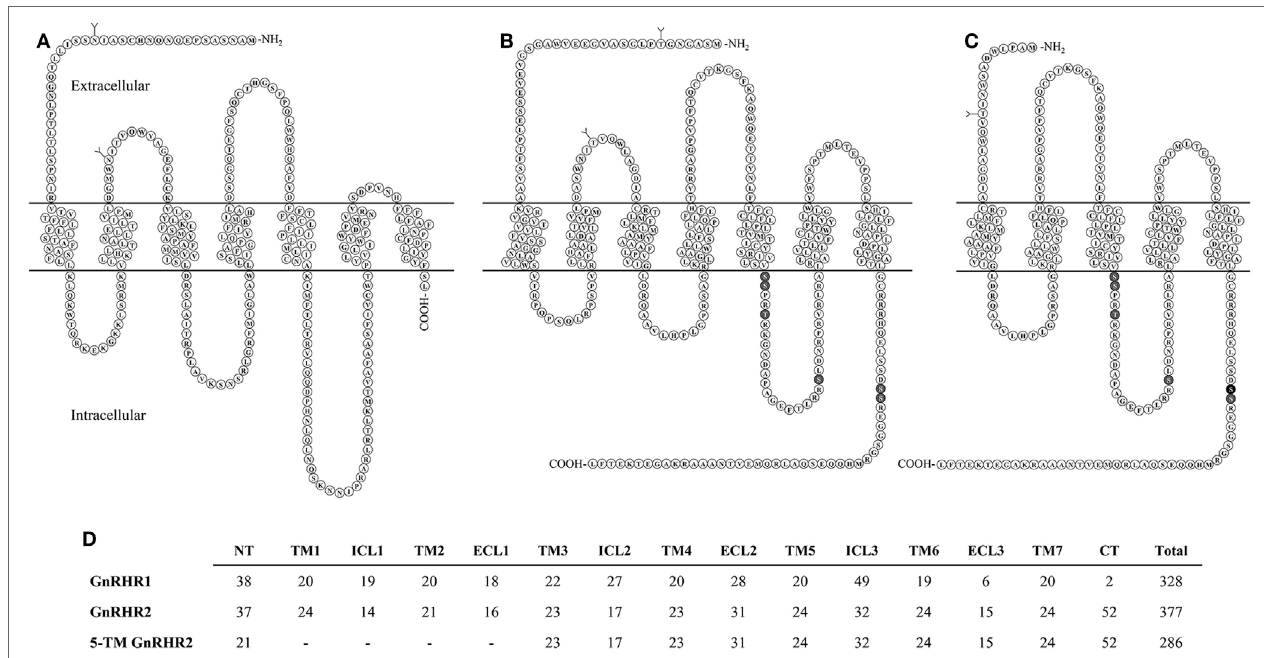
FiGURe 4 | Structural comparison of GnRHRs in the pig. (A) GnRHR1 (B) GnRHR2 and (C) predicted 5-transmembrane (TM) GnRHR2 in the pig. GnRHR1 and GnRHR2 are both 7-TM G-protein coupled receptors; however, GnRHR1 lacks a C-terminal tail present in GnRHR2. The 5-TM GnRHR2 isoform lacks TM domains 1 and 2 due to alternative splicing in exon 1 of the GnRHR2 gene, resulting in coupling of a truncated extracellular N-terminus directly to TM3. Glycosylation sites are represented by branched structures (Y) and the darkened residues in the GnRHR2 isoforms represent predicted sites of phosphorylation for internalization based on the work of Madziva et al. (102) and Ronacher et al. (103). Structures are predicted according to NCBI database records (GnRHR1, accession number NP_999438.1; GnRHR2, accession number AAS68622.1; 5-TM GnRHR2, accession number AAS68623.1). Adapted from Neill (80) and Neill et al. (82) with permission from Oxford University Press and Elsevier. (D) Comparison of residue number within each domain of GnRHR1, GnRHR2, and the predicted 5-TM GnRHR2 in the pig. Abbreviations: NT, extracellular N-terminus; TM, transmembrane; ICL, intracellular loop; ECL, extracellular loop; CT, C-terminal